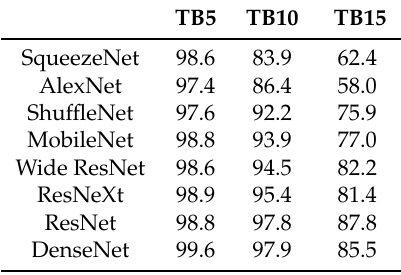
Table 9. Free-space TB5 inter-set test. Architectures trained on TB5 and tested against all TB data sets. TB5 TB10 TB15